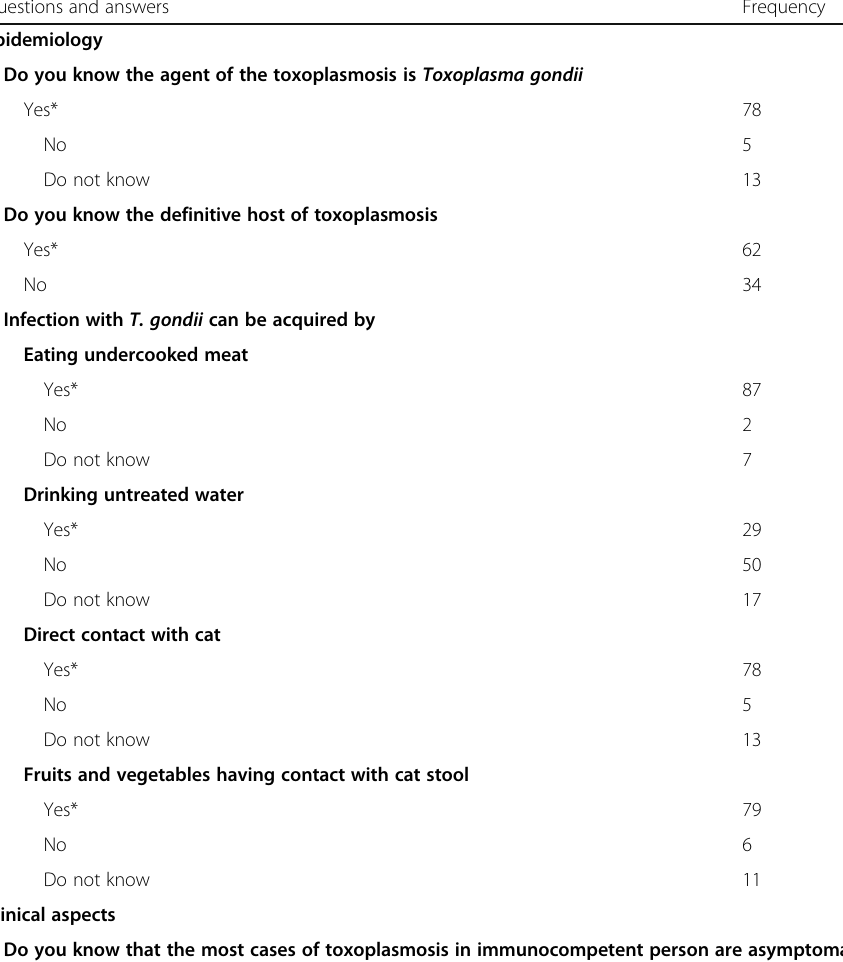
Table 2 Knowledge of parasite epidemiology, clinical aspects, diagnosis, and treatment of toxoplasmosis Questions and